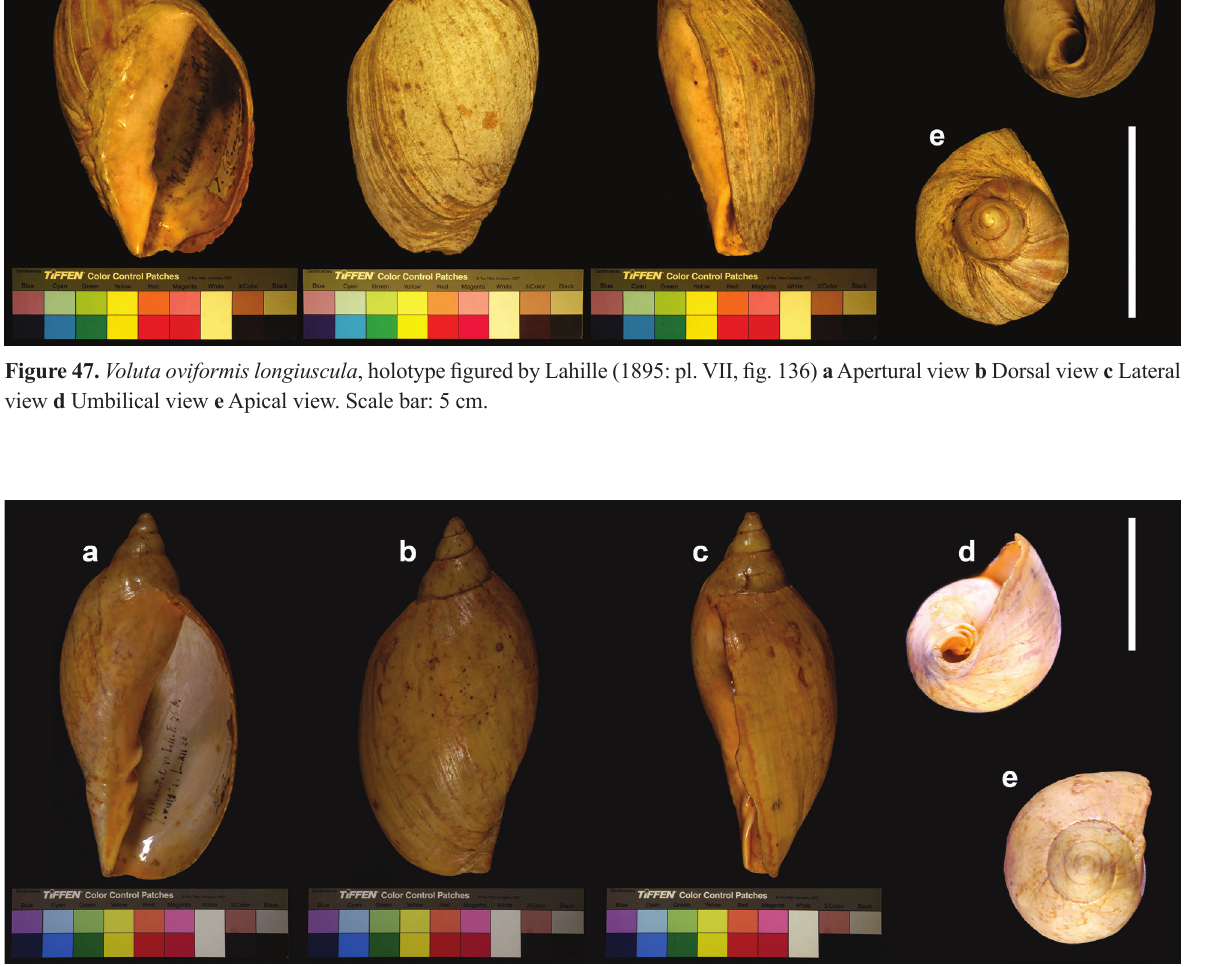
Table 20. Specimens of Voluta tuberculata typica figured by Lahille (1895) with the detail of the inscriptions on their shells and figures here and figures here.